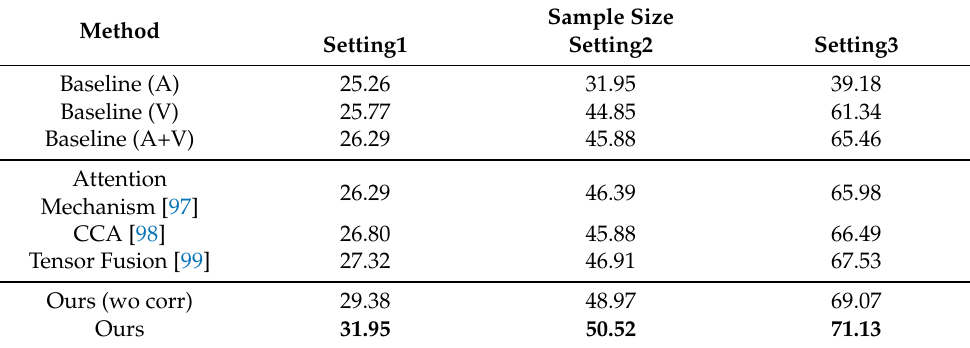
Table 1. Classification accuracy (%) of different methods on the eNTERFACE’05 dataset. Best results are shown in bold.